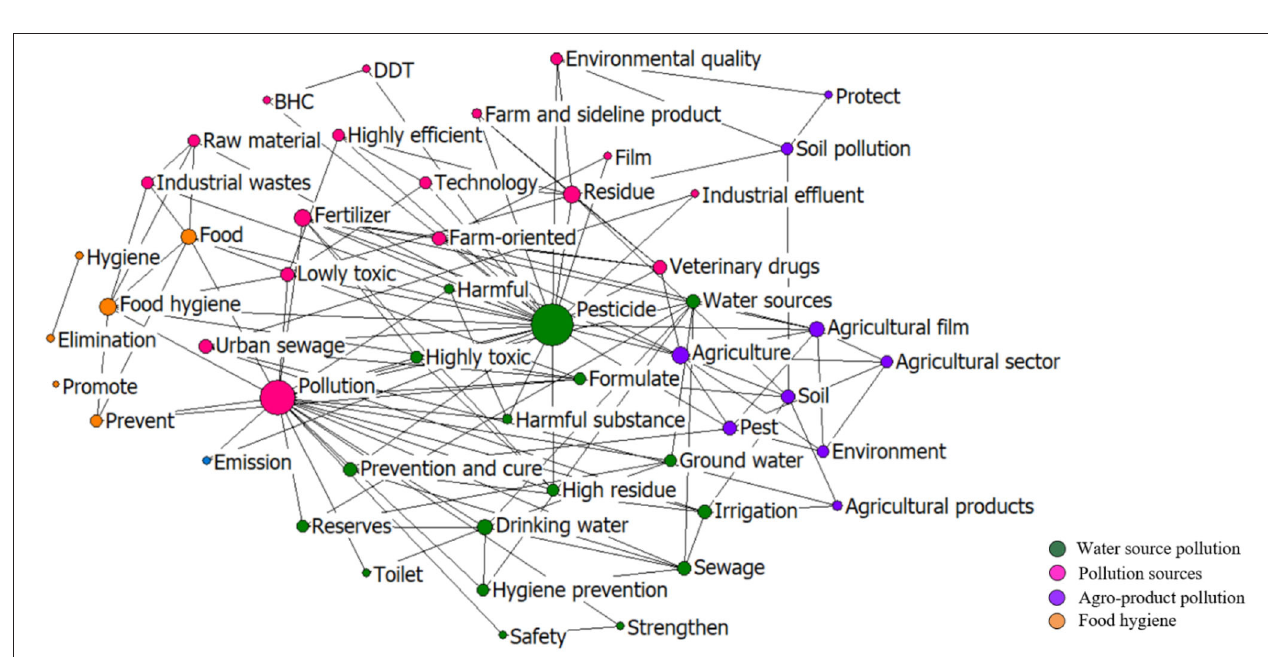
FIGURE 11 | The co-word network of the keywords in the policies in 1974–1994.